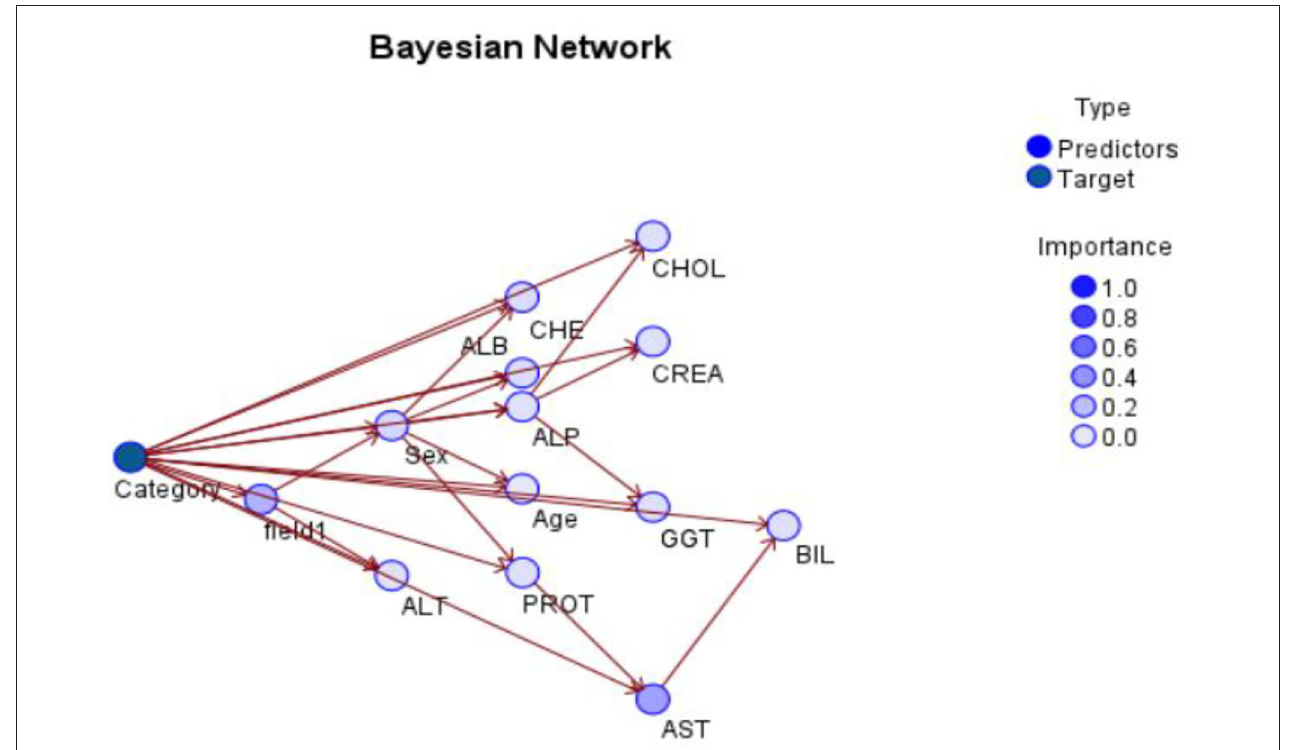
FIGURE 4 | Bayesian network for current